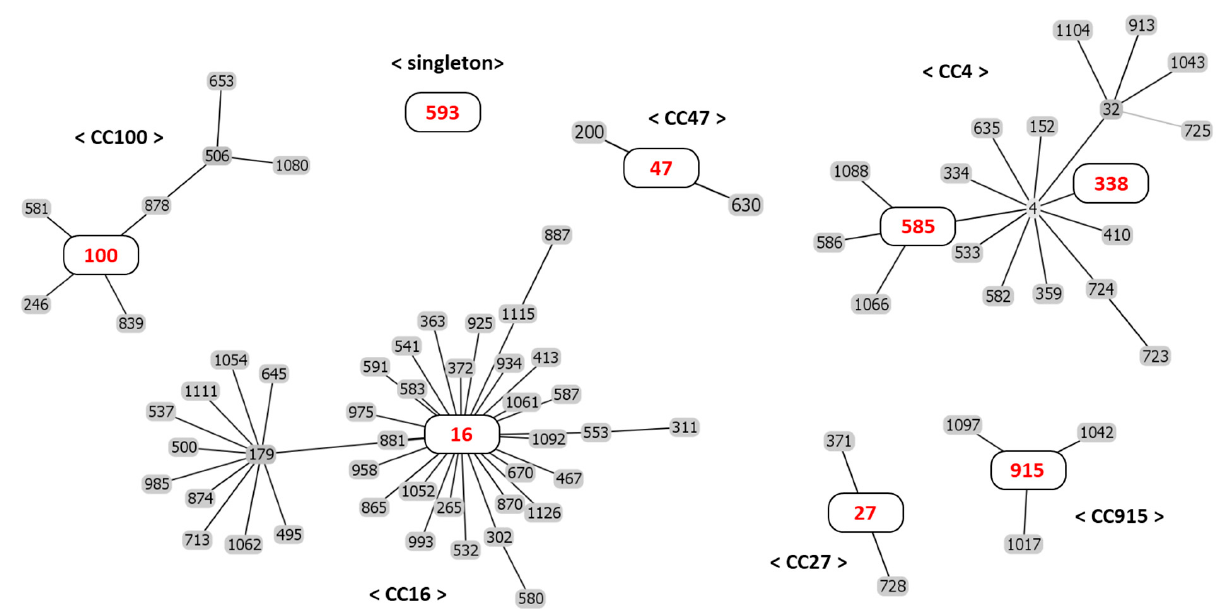
Figure 1. Graphical presentation of multilocus sequence typing data. Each ST analyzed in this study marked in red. The lines connect single-locus variants. The clonal relatedness between sequence types (STs) was analyzed against the entire E. faecalis database. Clonal complexes (CCs) are indicated. Eight sequence types (STs) were identified among the 20 E. faecalis isolates: ST593, ST100, ST16, ST27, ST338, ST47, ST585, and ST915. The eBURST algorithm clustered the STs into one singleton and six clonal complexes: CC100, CC16, CC27, CC4, CC47, and CC915.